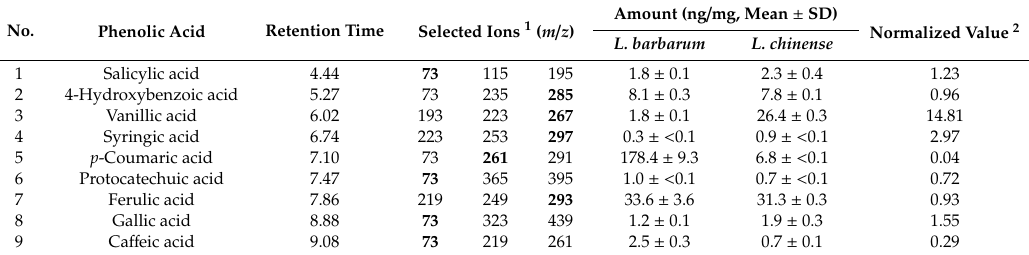
Table 2. Phenolic acid levels in L. chinense and L. barbarum